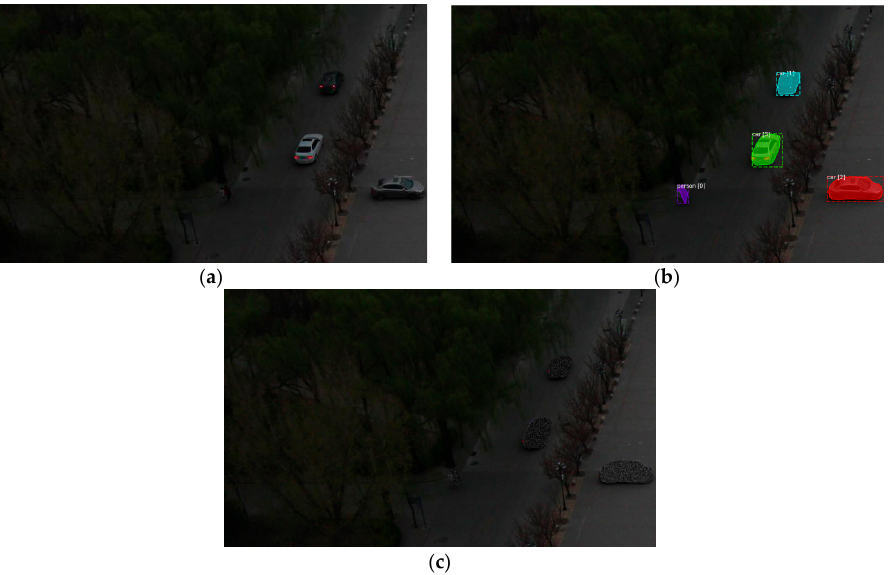
Figure 12. ( a ) The image in experiment 3; ( b ) the result of instance segmentation; ( c ) covering the objects with similar color masks.